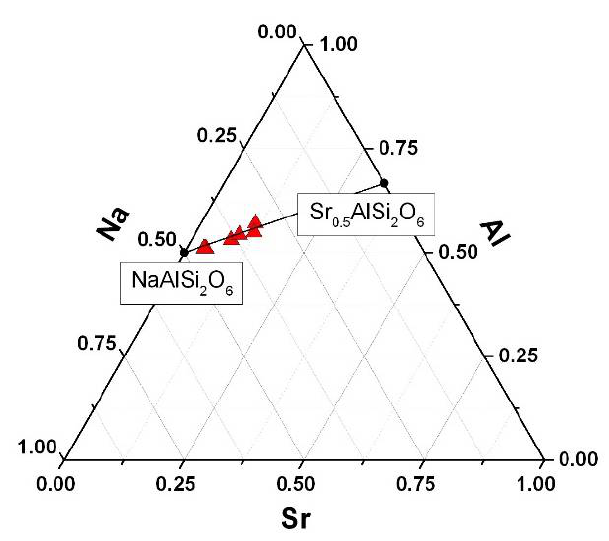
Figure 6. Composition of solid solutions (Na 1−n Sr n/2 )AlSi 2 O 6 ·H 2 O in Na-Sr-Al coordinates (at.%) by SEM-EDS data.